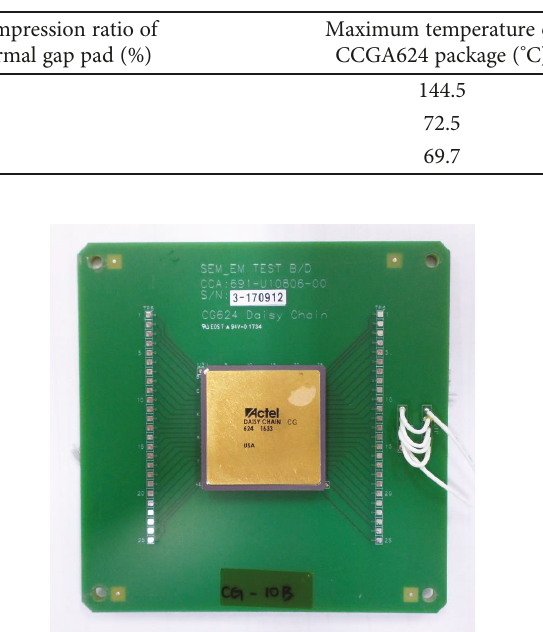
Figure 5: PCB specimen with CCGA624